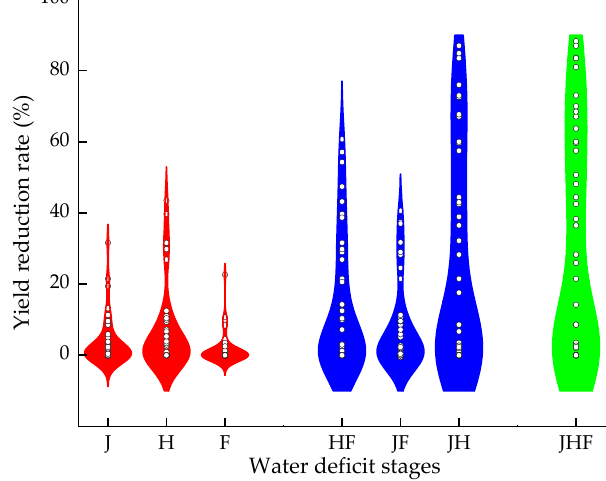
Figure 9. Simulated yield reduction rate during different water deficit stages of summer maize from 1970 to 2015.